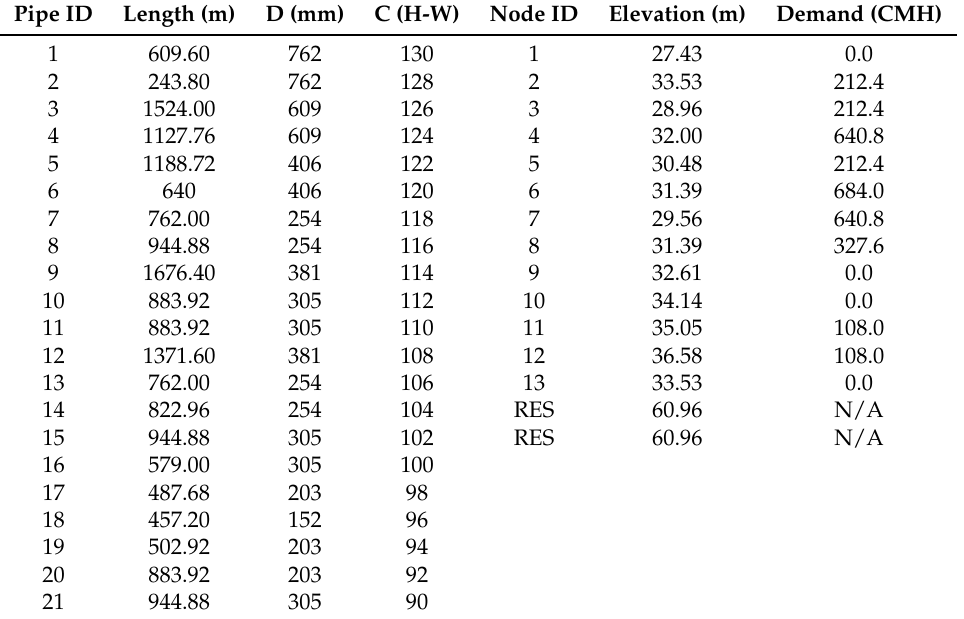
Figure 3. Schematic for Illustrative Example 1 Ozger [50]. Table 1. Pipe